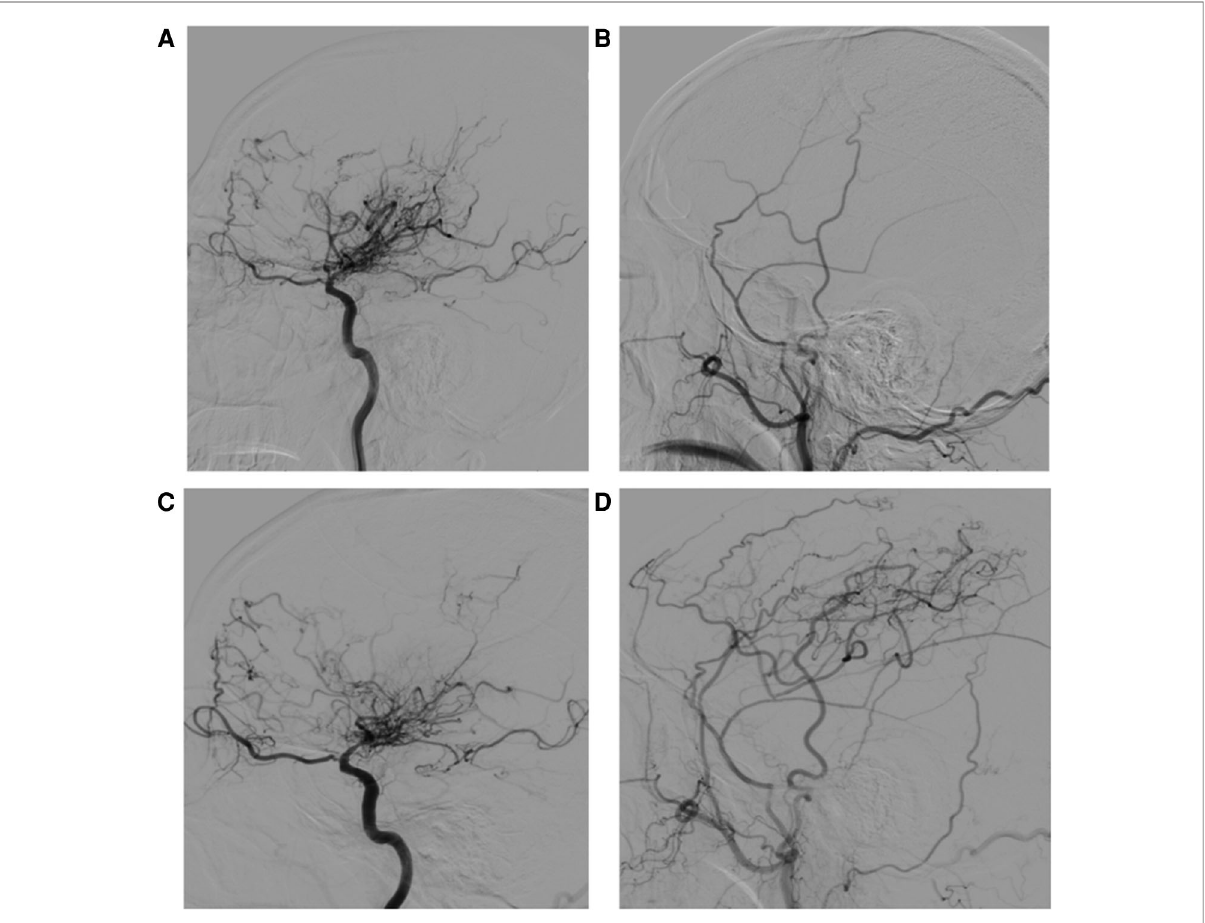
FIGURE 3 A 55-year-old man whose initial symptom was cerebral infarction. ( A ) Preoperative right internal carotid artery (ICA) angiogram (lateral view) reveals distal internal carotid artery occlusion with moyamoya collaterals. ( B ) Preoperative external carotid artery injection. ( C ) Postoperative right ICA angiogram (lateral view) 11 months after STA-MCA anastomosis with MBH and dural inversion showing decreased moyamoya vessels. ( D ) Early arterial-phase postoperative external carotid artery injection. Patency of the STA-MCA anastomosis was noted, and marked neovascularization associated with the frontal branch of the super fi cial temporal artery (F-STA), the deep temporal artery (DTA) and middle meningeal artery (MMA) was observed. The distal STA before the bifurcation increased in size by 43.2%, the F-STA increased by 10.2%, the DTA increased by 100%, and the MMA increased by